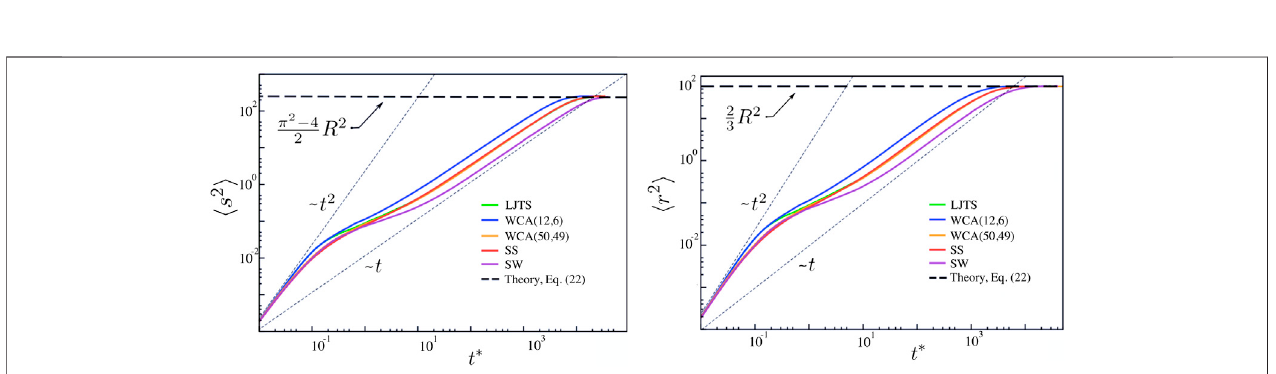
FIGURE 3 | MSD of interacting particles over the sphere with the potentials given in Figure 1 . The geodesic arc, 〈 s 2 〉 , and the projected displacement in the XY plane, 〈 r 2 〉 , are plotted at left and right, respectively.